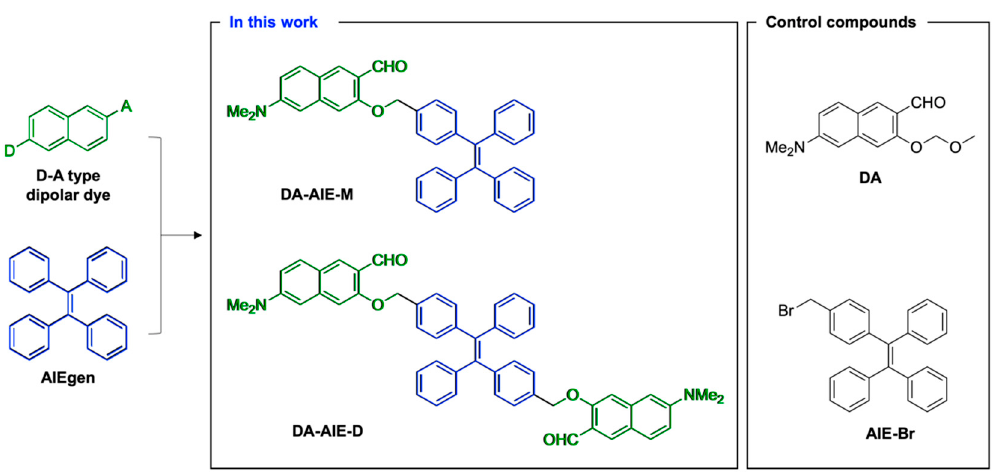
Figure 1. Chemical structure of D-A type naphthalene-based dipolar dye and tetraphenylethylene-based AIEgen. In this work: articulated structures of D-A type dipolar dye with AIEgen; DA-AIE-M and DA-AIE-D. Control compounds: non-articulated compounds on behalf of dipolar dye (DA) and AIEgen (AIE-Br).